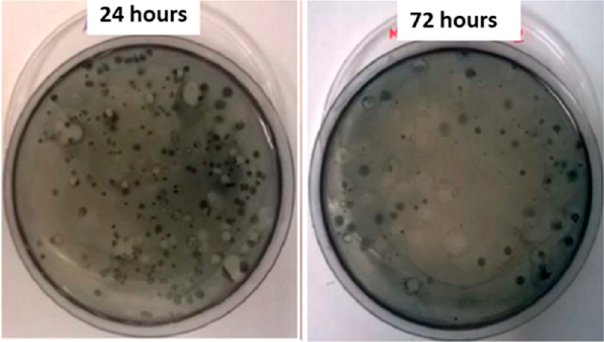
Figure 2. SBB staining of PHA producers at 24 h ( left ) and 72 h ( right ) of fermentation.